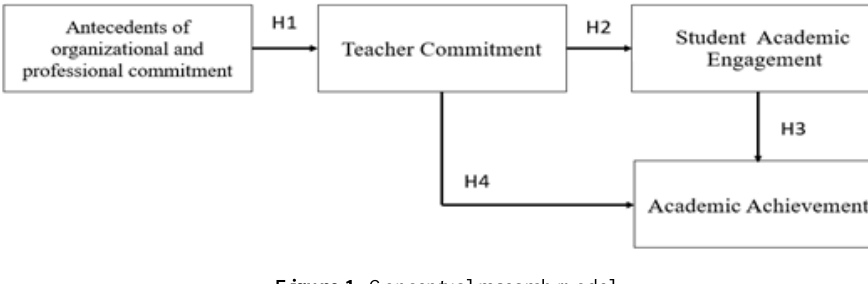
Figure 1: Conceptual research